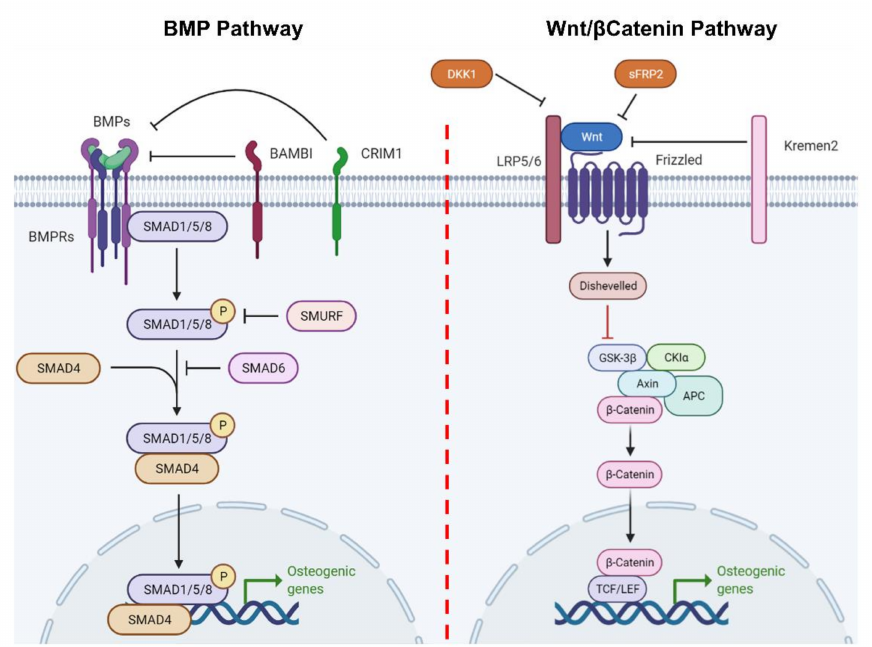
Figure 1. Conventional osteogenic differentiation pathways. Cartoon showing the two classical osteogenic differentiation pathways of MSCs/preosteoblasts, i.e., the bone morphogenic pathway and the Wnt/ β -catenin pathway. BMPRs—BMP receptors; BAMBI—BMP and activin membrane- bound inhibitor homolog; CRIM1—cysteine-rich motor neuron 1 protein; SMAD—small mothers against decapentaplegic; DKK1—Dickkopf-related protein 1; sFRP2—secreted frizzled-related pro- tein 2; Kremen—Kringle domain-containing transmembrane protein; LRP—Low Density Lipopro- tein Receptor-Related Protein; GSK—glycogen synthase kinase; CKI α —casein kinase I α ; APC— adenomatous polyposis coli; TCF/LEF—T-cell factor/lymphoid enhancer-binding factor. Created with biorender.com.